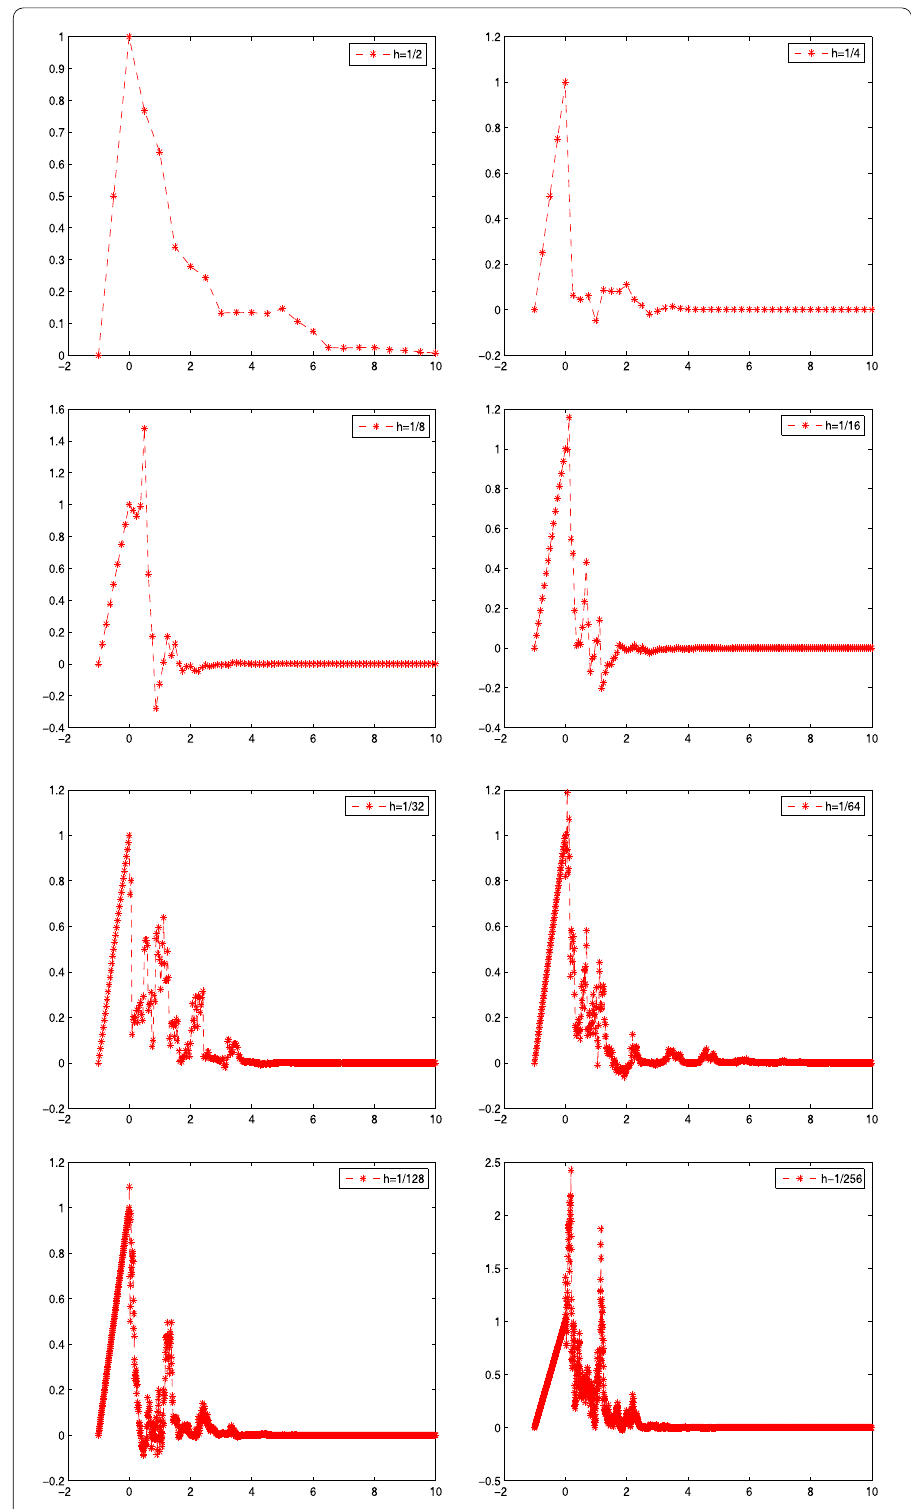
Figure 1 The numerical solutions with h = 1/2,1/4,1/8,1/16,1/32,1/64,1/128,1/256 for